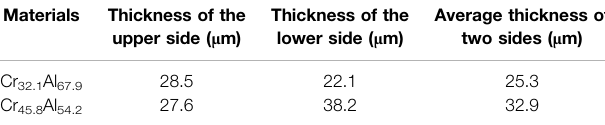
TABLE 3 | Thickness of various ATF coatings with 6 h deposition. Materials Thickness of the upper side ( μ